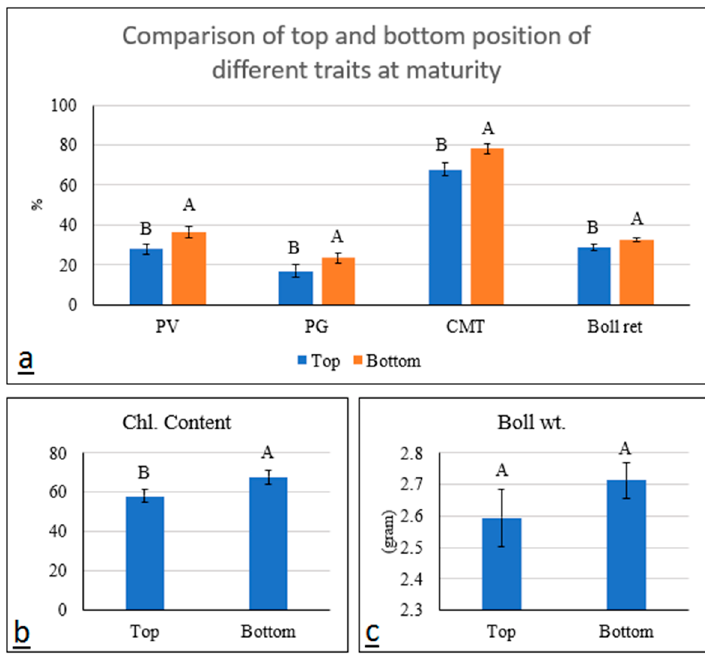
Figure 3. Means averaged across all genotypes to compare top and bottom positions of plants for different traits at maturity. The error bars are standard errors. The letters show Tukey’s mean comparison where different letters show significant differences between top and bottom positions for each trait. ( a ) PV (Pollen viability), PG (Pollen germination), CMT (Cell membrane thermostability) and boll ret (boll retention), ( b ) Chl. Content (Chlorophyll content), ( c ) Boll wt (Boll weight).